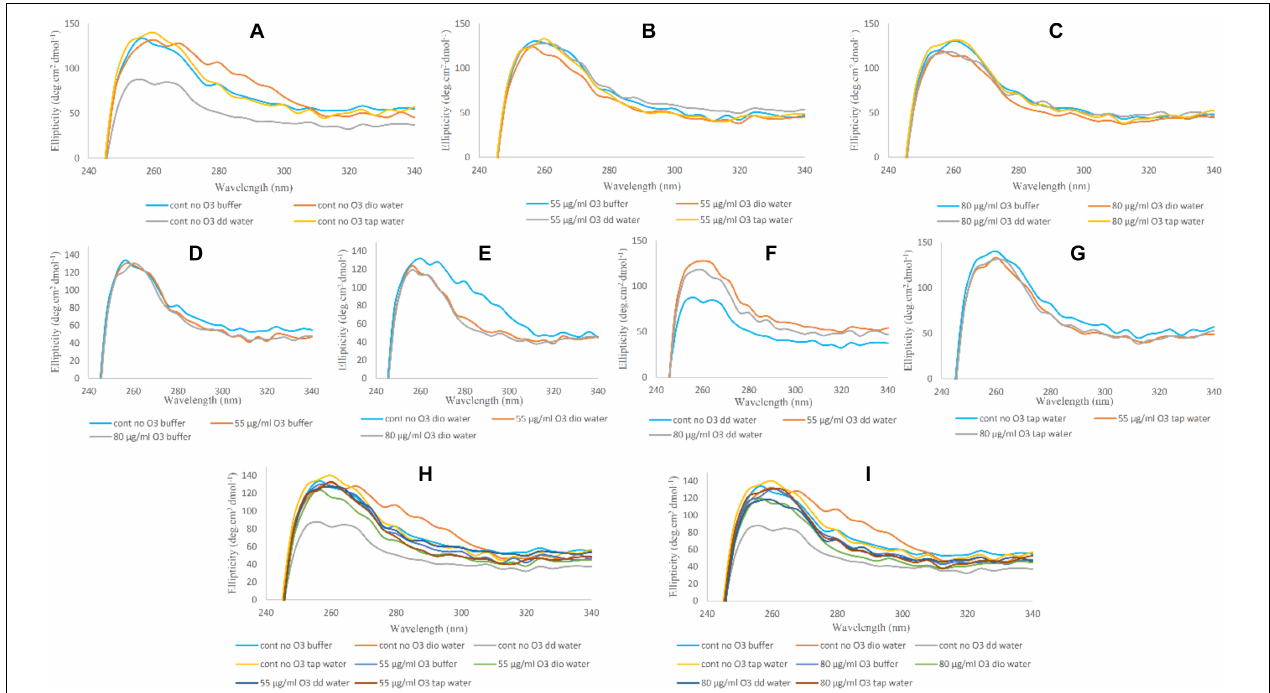
FIGURE 4 | Near-UV CD spectra of non-ozonated and ozonated Hb samples in the presence of phosphate buffer and diluted versions with different water types. (A) Non-ozonated Hb in phosphate buffer and different water types. (B) Hb ozonated with 55 µ g/ml ozone in phosphate buffer and different water types. (C) Hb ozonated with 80 µ g/ml ozone in phosphate buffer and different water types. (D) Non-ozonated and ozonated Hb with 55 and 80 µ g/ml ozone in phosphate buffer. (E) Non-ozonated and ozonated Hb with 55 and 80 µ g/ml ozone in phosphate buffer diluted with deionized (Dio) Water. (F) Non-ozonated and ozonated Hb with 55 and 80 µ g/ml ozone in phosphate buffer diluted with double distilled (DD) Water. (G) Non-ozonated and ozonated Hb with 55 and 80 µ g/ml ozone in phosphate buffer diluted with Tap Water. (H) Non-ozonated and ozonated Hb with 55 µ g/ml ozone in phosphate buffer and diluted in various different water types. (I) Non-ozonated and ozonated Hb with 80 µ g/ml ozone in phosphate buffer and diluted in various different water